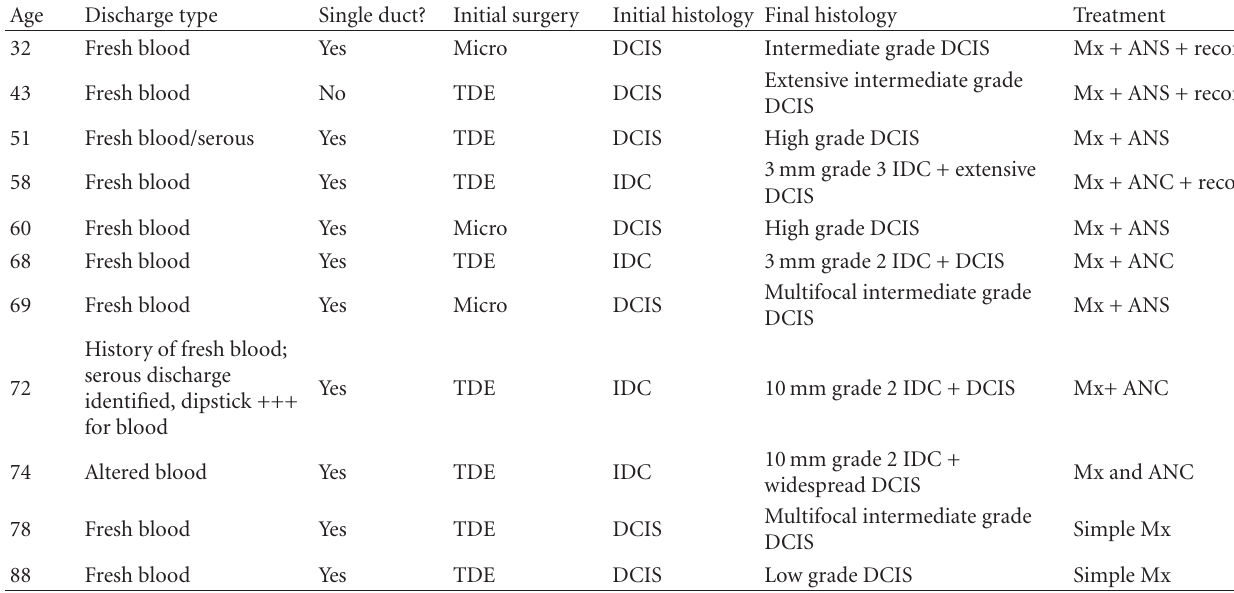
Table 2: Breast cancers identified following surgery for spontaneous isolated nipple discharge.